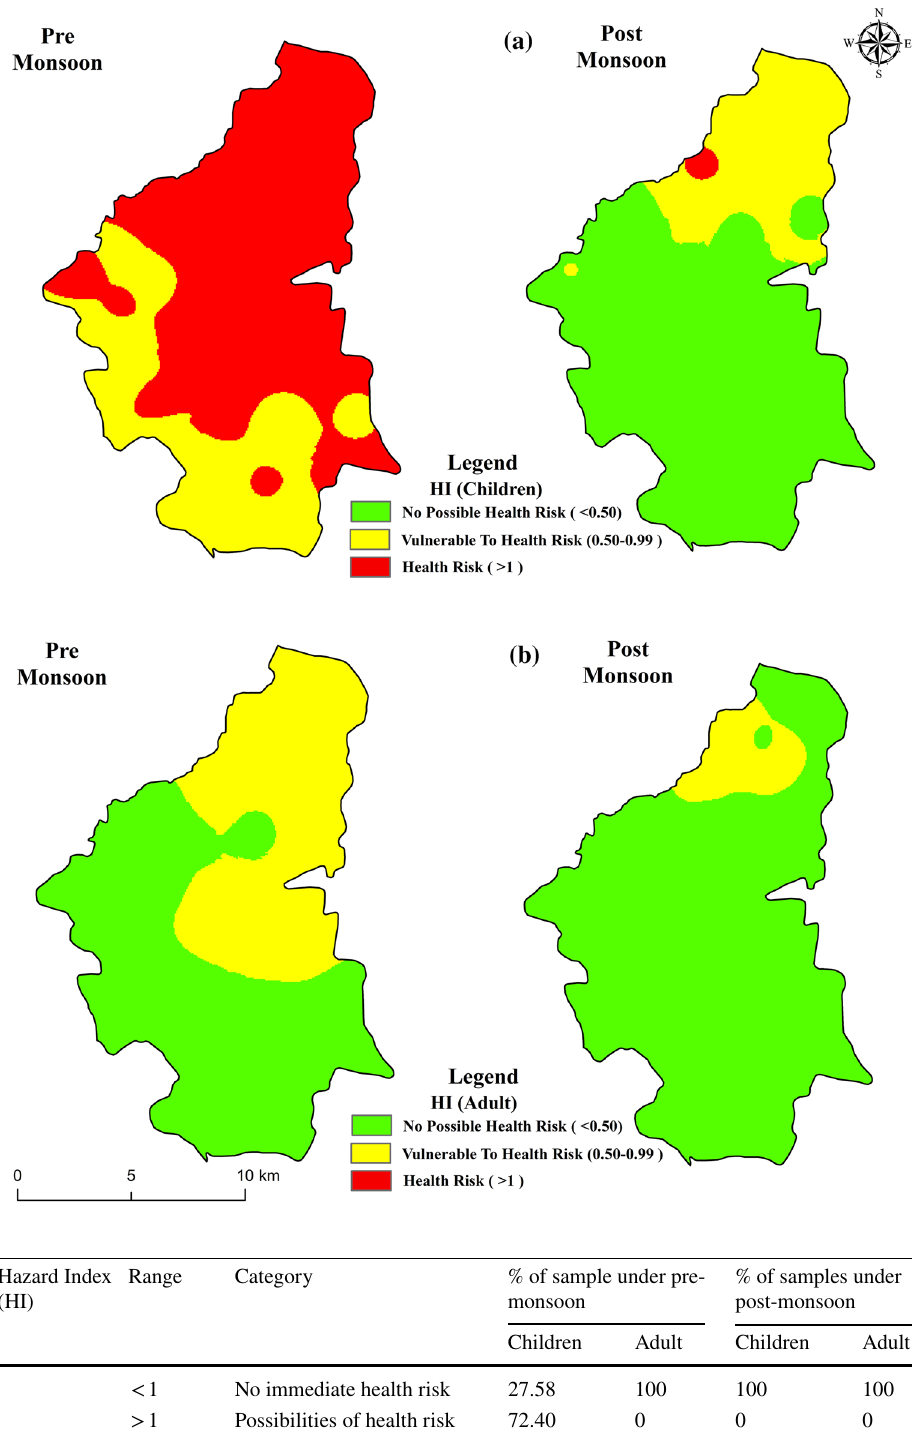
Fig. 4 Spatial distribution of